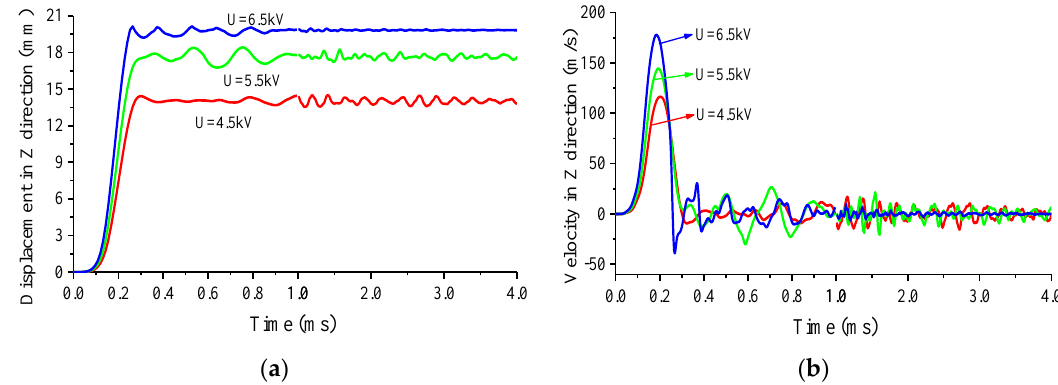
Figure 16. Change of central node’s: displacement ( a ); and velocity ( b ) at different U ( C = 320 μF).